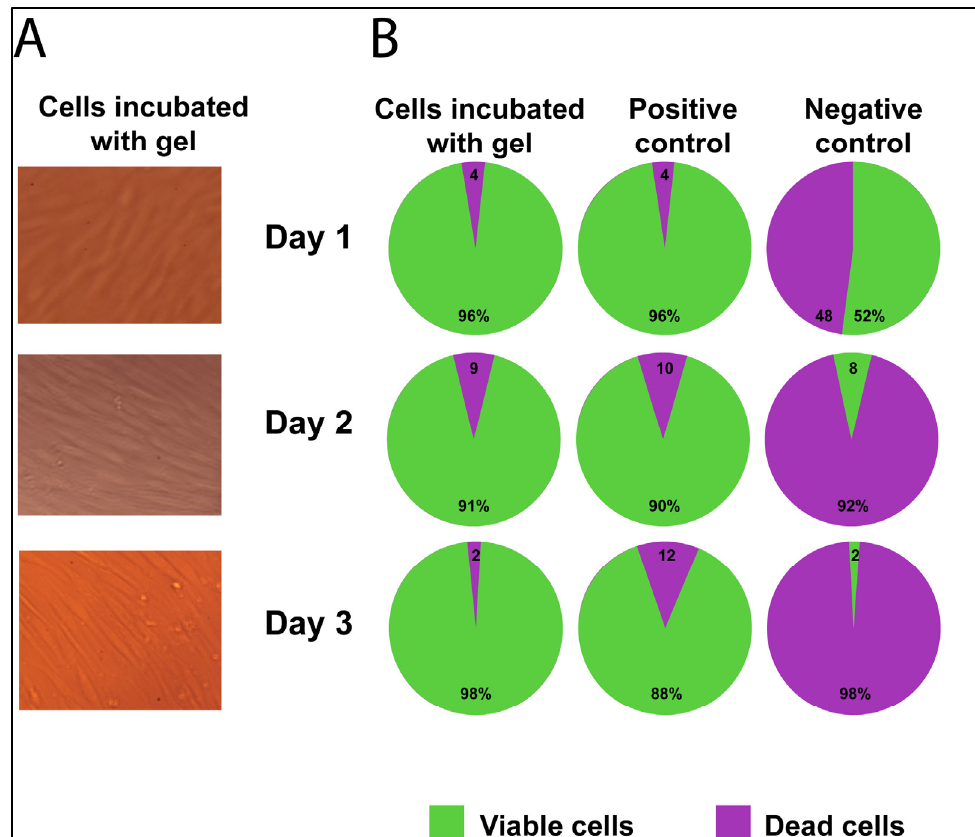
Figure 2. Cell viability/cytotoxicity of fibroblasts, observed during three days of culture with the gel. ( A ). Cell culture microscopy images. ( B ). Live/dead cells ratio (flow cytometry with Calcein-AM and 7-AAD dyes).